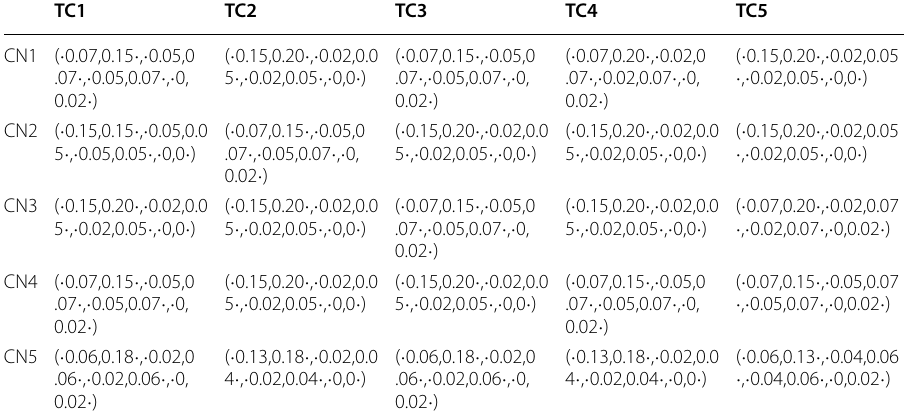
Table 27 Weighted DMT for the phase 1 of